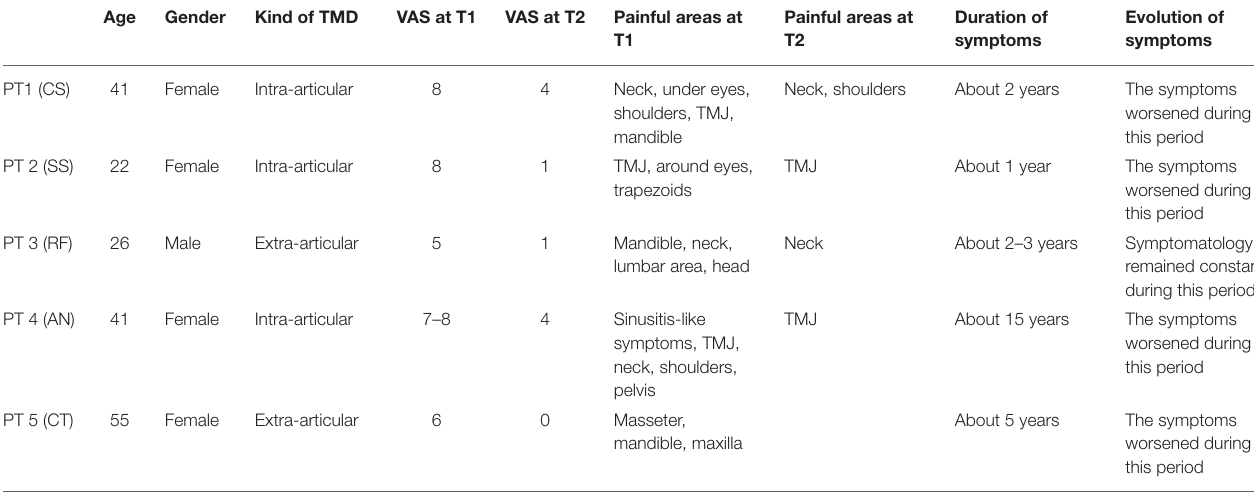
TABLE 1 | Clinical and demographical characteristics of the patients and the impact of the gnathological treatment. Age Gender